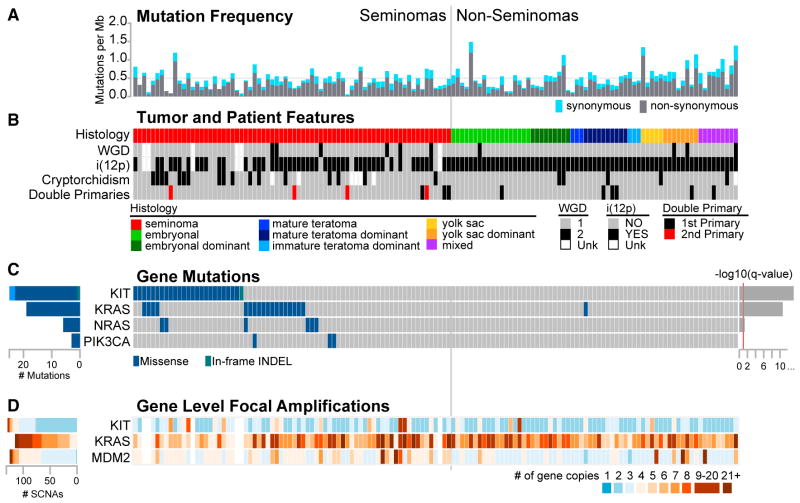
Molecular Alterations and Features across 137 TGCT Samples(A) Somatic mutation frequency (mutations/Mb) from exome sequencing. The horizontal gray dashed line marks the median mutation rate of 0.5 mutations/Mb. The vertical gray line divides pure seminomas from NSGCTs.(B) Tumor and patient features per sample. Whole genome doubling (WGD) and i(12p) status are using the ABSOLUTE algorithm. Calls for WGD or inferred i(12p) status could not be made for six low-purity samples. Cryptorchidism status, family history of testicular germ cell tumor (TGCT) or other cancer, and presence of double primaries are displayed. Unk, unknown.(C) Significant recurrent mutations (KIT, KRAS, and NRAS) or curated based on frequency or biological relevance.(D) Three known oncogenes were significantly focally amplified. Values represent the number of gene copies detected using the ABSOLUTE integer copy number.See also Figures S2 and S3 and Table S3.